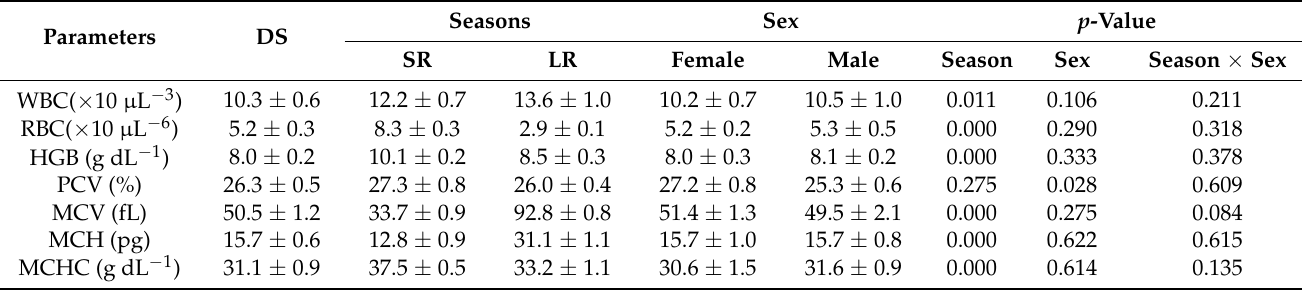
Table 4. Effect of season on hematological parameters (mean ±